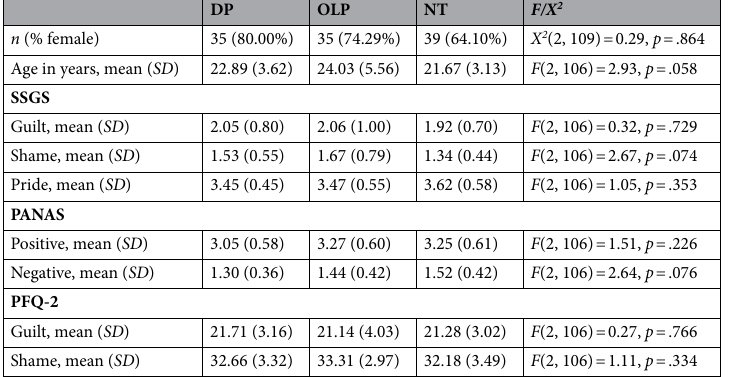
Table 1. Baseline between-group comparisons on demographic and outcome measures. SD , standard deviation; DP, deceptive placebo; OLP, open-label placebo; NT, no treatment; SSGS, State Shame and Guilt Scale; PANAS, Positive and Negative Affect Schedule; PFQ-2, Personal Feelings Questionnaire